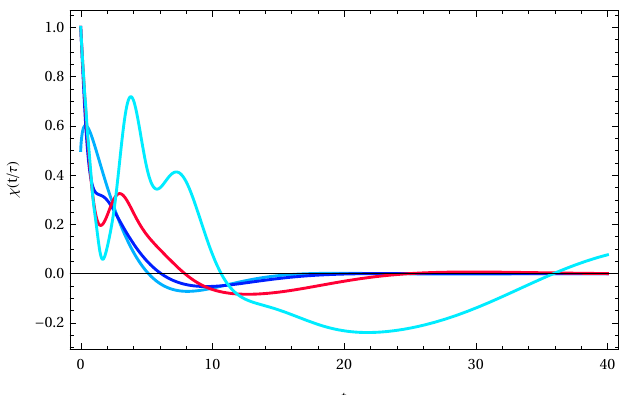
Figure 19. Variable order fractional relaxation with α ( t ) = 1 − t k e − t and k = 0,1,2,3. The number of Sinc points is N = 128.